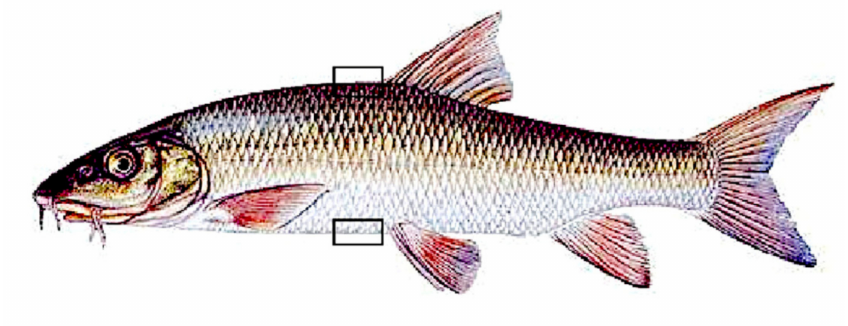
Figure 1. Location of sample collection.